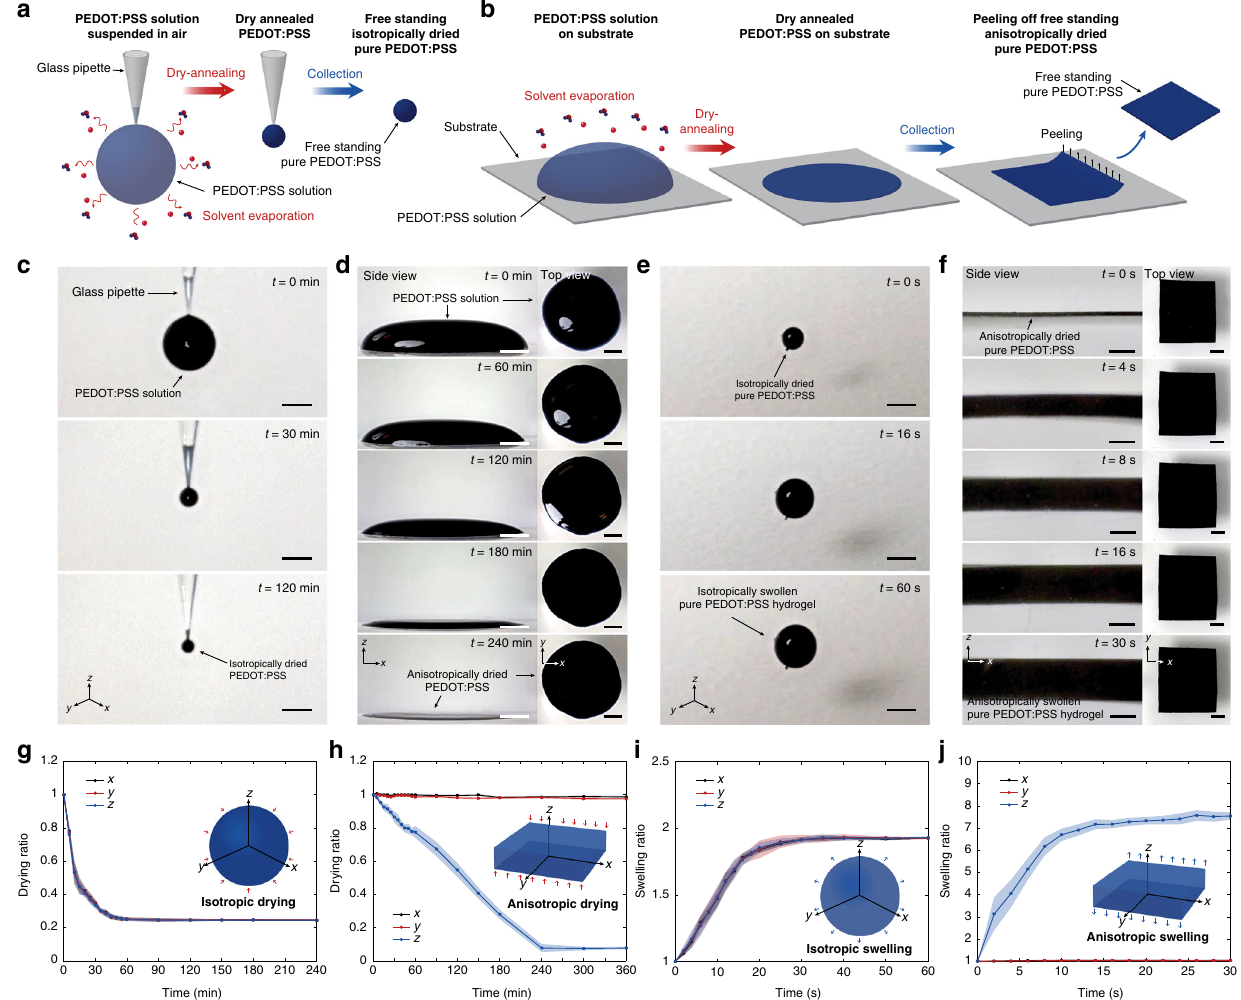
Fig. 2 Dry-annealing and swelling behaviors of pure PEDOT:PSS hydrogels. a Schematic illustration of isotropic dry-annealing of aqueous PEDOT:PSS solution into a microball. b Schematic illustration of anisotropic dry-annealing of aqueous PEDOT:PSS solution into a free-standing fi lm. c Experimental images for isotropic dry-annealing of aqueous PEDOT:PSS solution into a microball. d Experimental images for anisotropic dry-annealing of aqueous PEDOT:PSS solution into a free-standing fi lm. e Isotropic swelling of a pure dry-annealed PEDOT:PSS microball into a stable hydrogel. f Anisotropic swelling of a free-standing pure dry-annealed PEDOT:PSS fi lm into a stable hydrogel. g , h Dimensional changes vs. time during the g isotropic and h anisotropic dry- annealing of aqueous PEDOT:PSS solution. i , j Dimensional changes vs. time during the i isotropic and j anisotropic swelling of pure PEDOT:PSS hydrogels. Values in g – j represent mean and the error bars represent the SD of the measured values ( n = 3). Scale bars, 1 mm NATURE COMMUNICATIONS| (2019) 10:1043